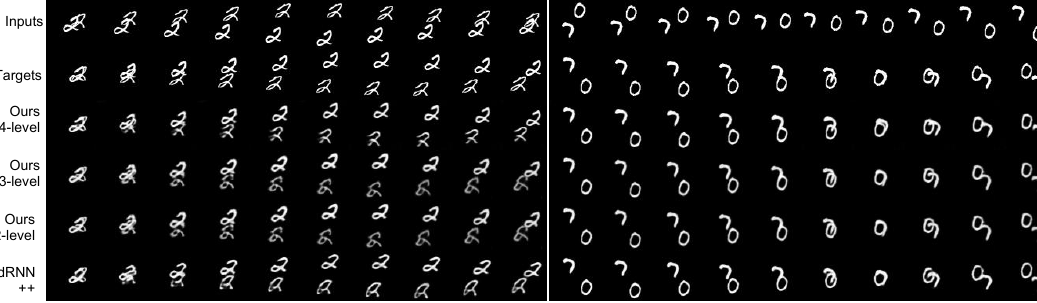
Figure 5. Qualitative results on MMNIST. Our model is able to generates sharp frames during all the time steps, and accurately predicts the digit locations.